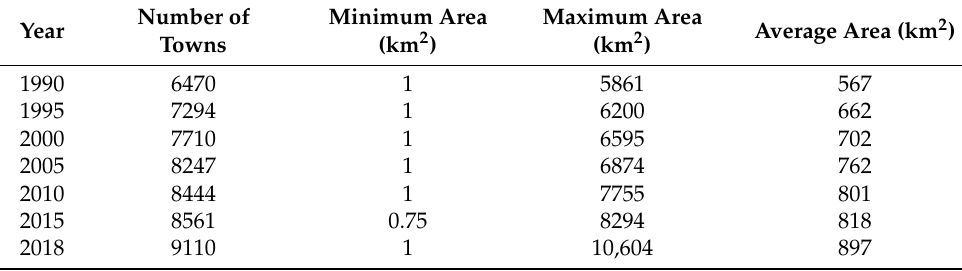
Table 2. Characteristics of the Global Urban Boundary (GUB)